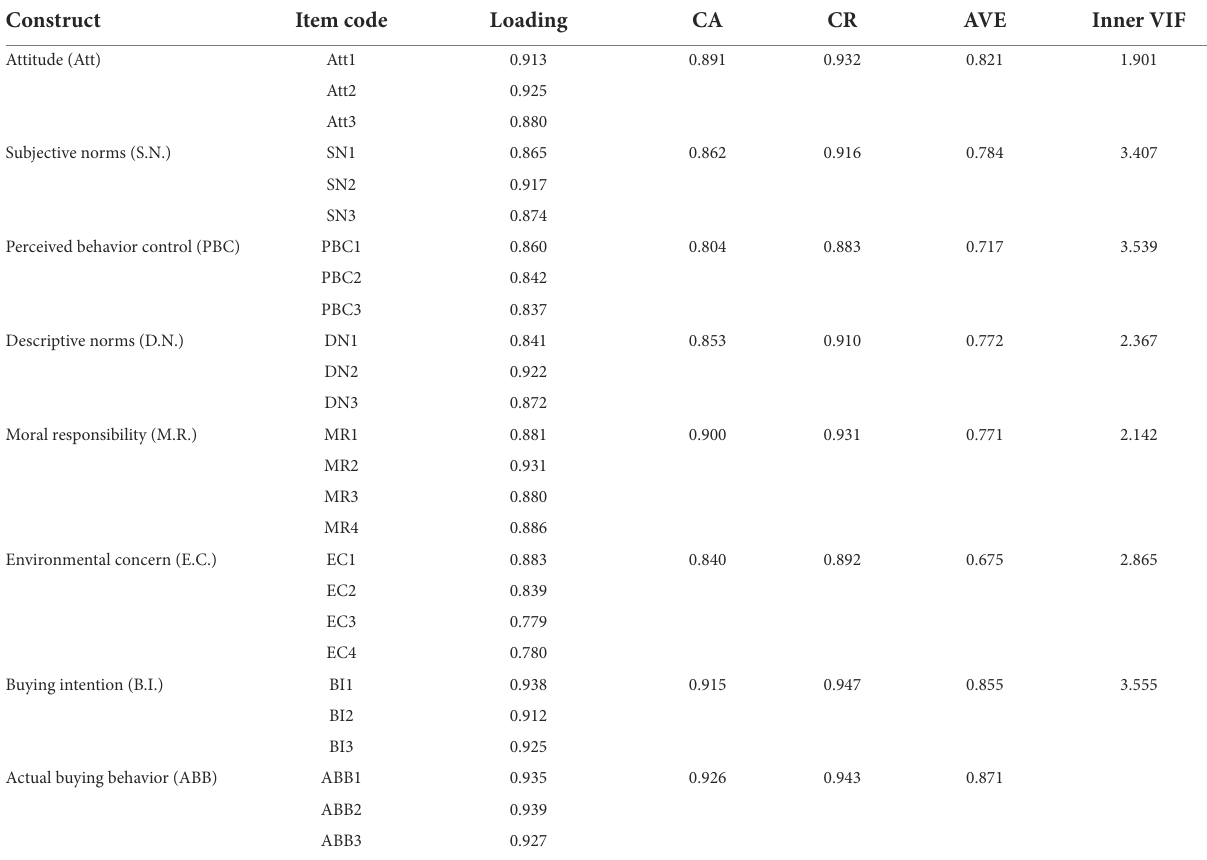
TABLE 2 Results of the measurement